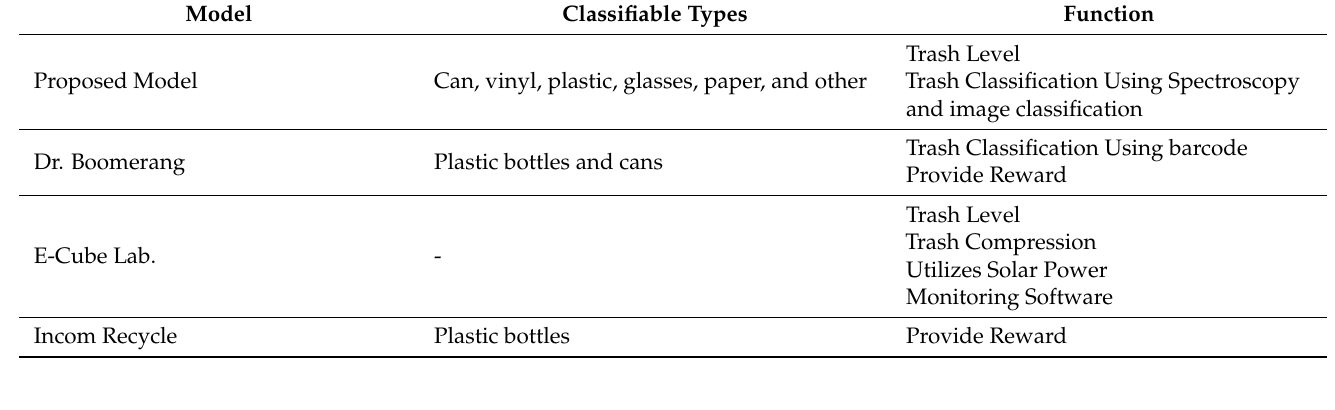
Table 5. Comparison of Each Model.